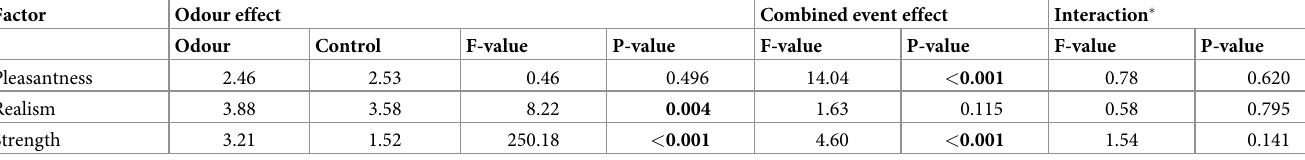
Bold values highlight significant findings.